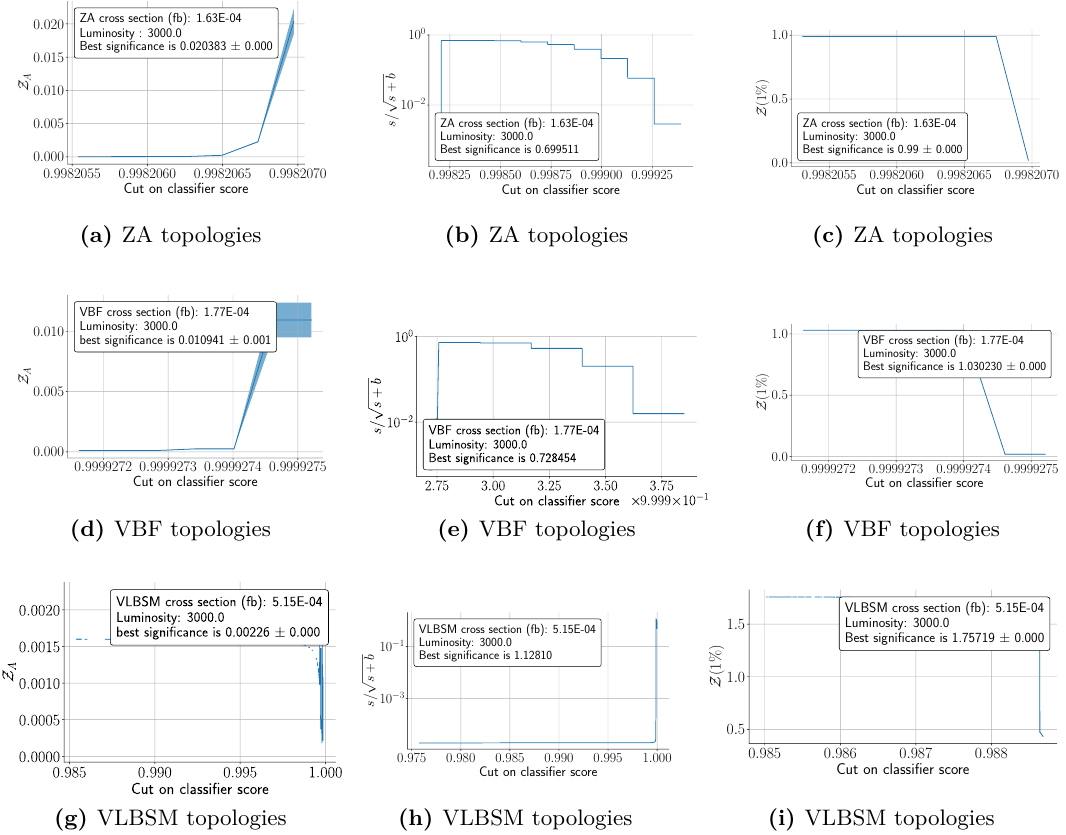
Figure 15. Statistical significance as a function of the classifier score given by NN for each signal graph, assuming the lightest VLL with mass m E = 200 GeV and a luminosity L = 3000 fb − 1 . 2 All showcased plots are representative of the best NN found, following a genetic algorithm that maximizes the Asimov significance. For plots (a), (d) and (g) we present the Asimov significance, √ s + b and for (c), (f) and (i) with 1% systematics, for (b), (c) and (h) — the standard significance s/ — the adapted Asimov significance, where it is assumed that backgrounds are known with error 10 − 3